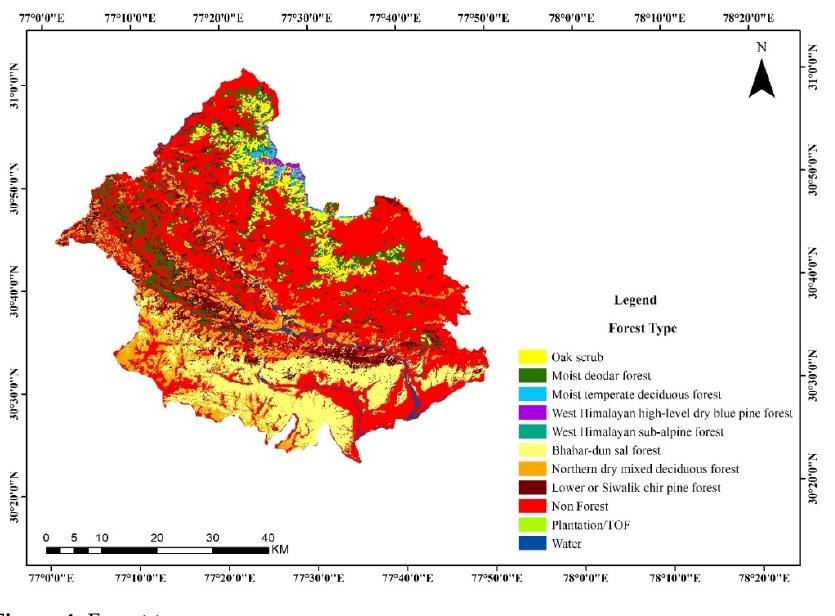
Figure 4. Forest type map.